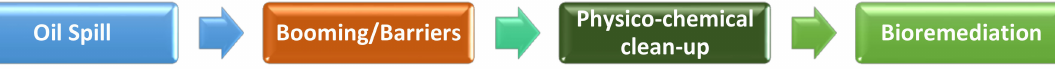
Figure 6. Proposed steps for complete oil spill treatment/clean-up in seawater.